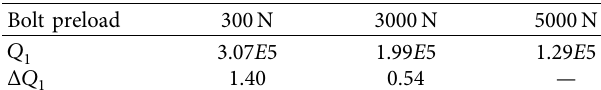
Table 10: Q and Δ Q under different bolt preload (impact ex- 1 1 periment of the connection structure with 4